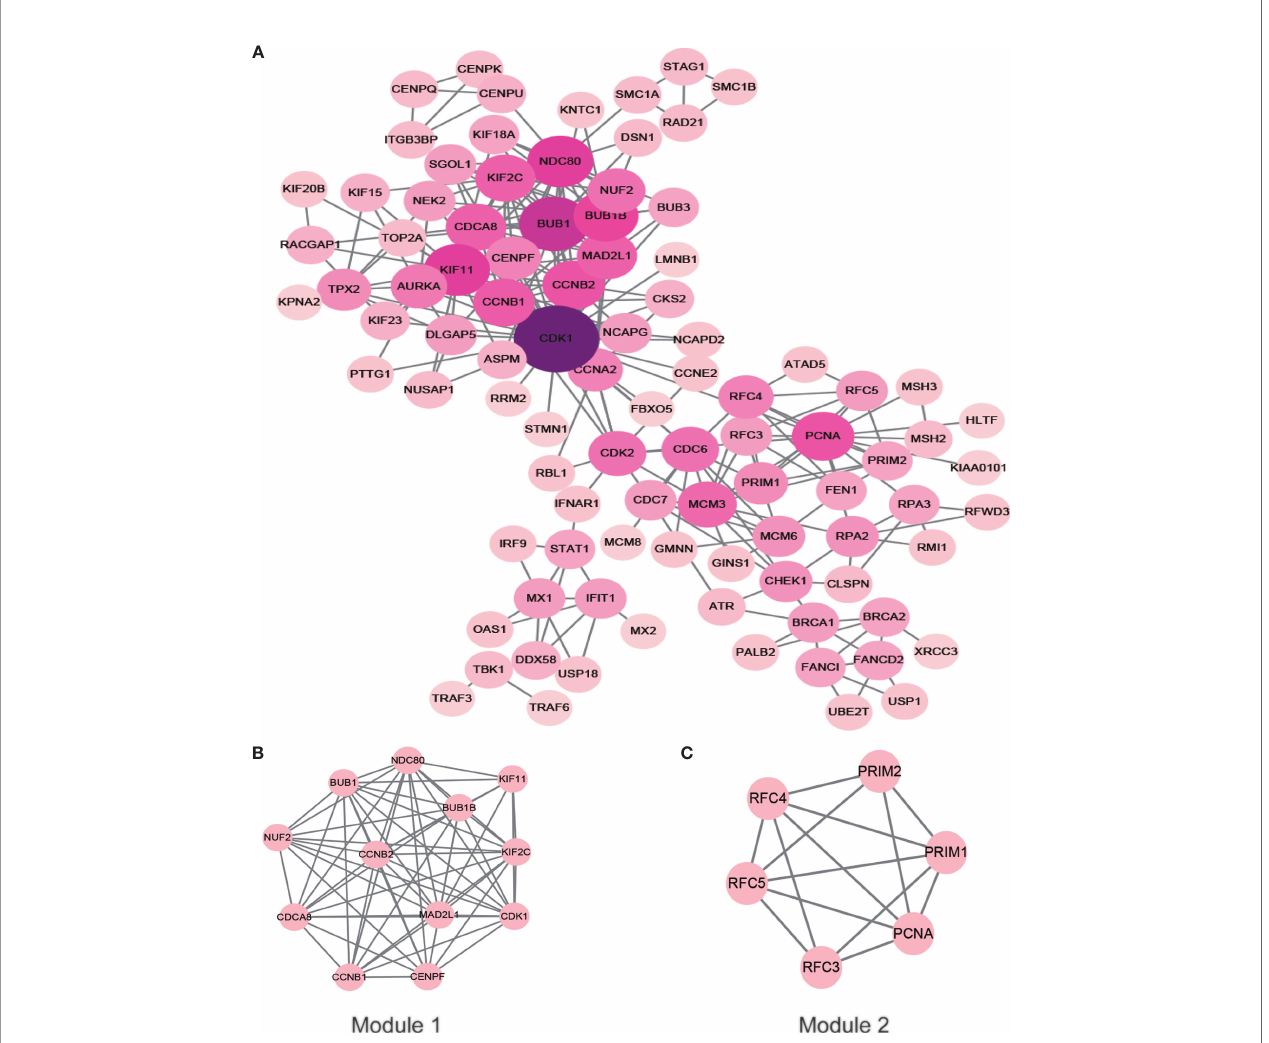
FIGURE 6 | PPI network of the hub genes. The color of the node represents the degree of that node. The edges represent interactions. (A) PPI analysis and hub gene screening of target genes. (B, C) Top two modules with the highest score (Modules 1 and 2). PPI, protein-protein